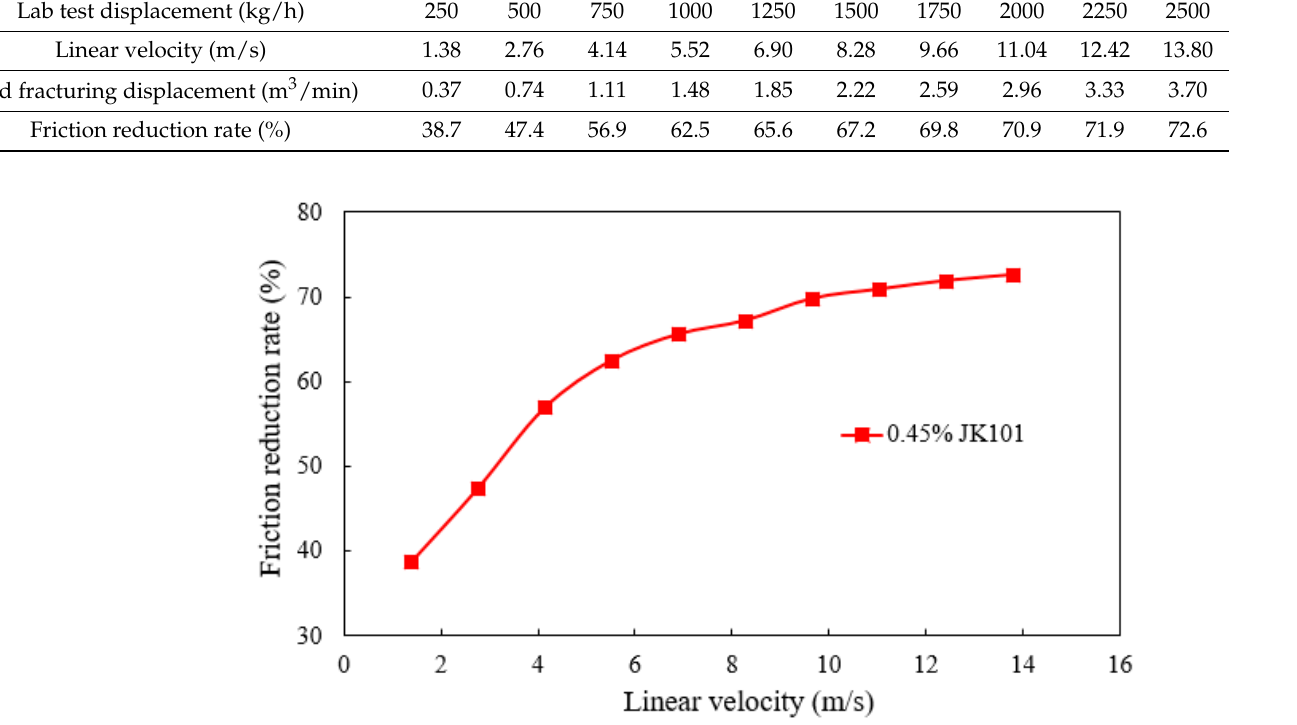
Figure 10. The friction reduction rate varied with the linear velocity.